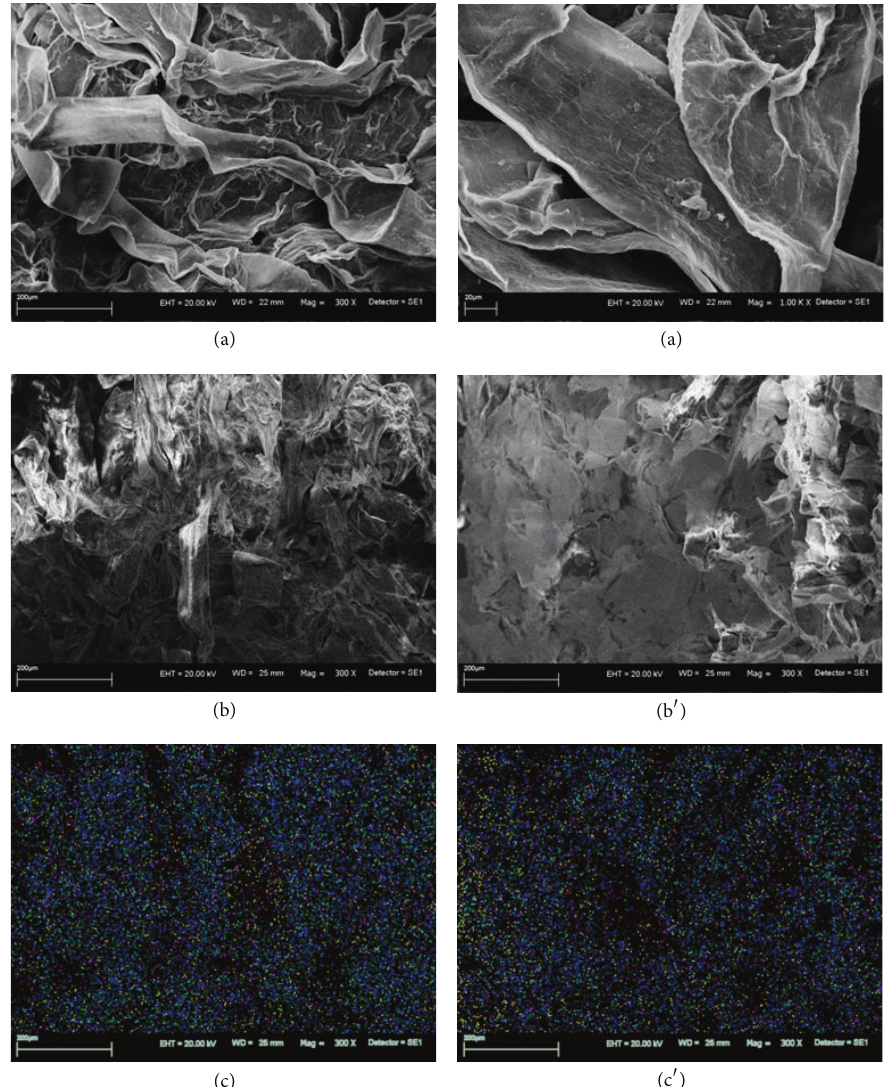
Figure 1: (a) A picture of the surface of natural biomass — Vaucheria sessilis ; bottom picture of the surface (b) and cross section (b 󸀠 ) of macroalga; mapping of all elements on the surface (c) and in the cross section (c 󸀠 ) (C — green, O — dark blue, Na — bright blue, Al — yellow, Si — purple, and